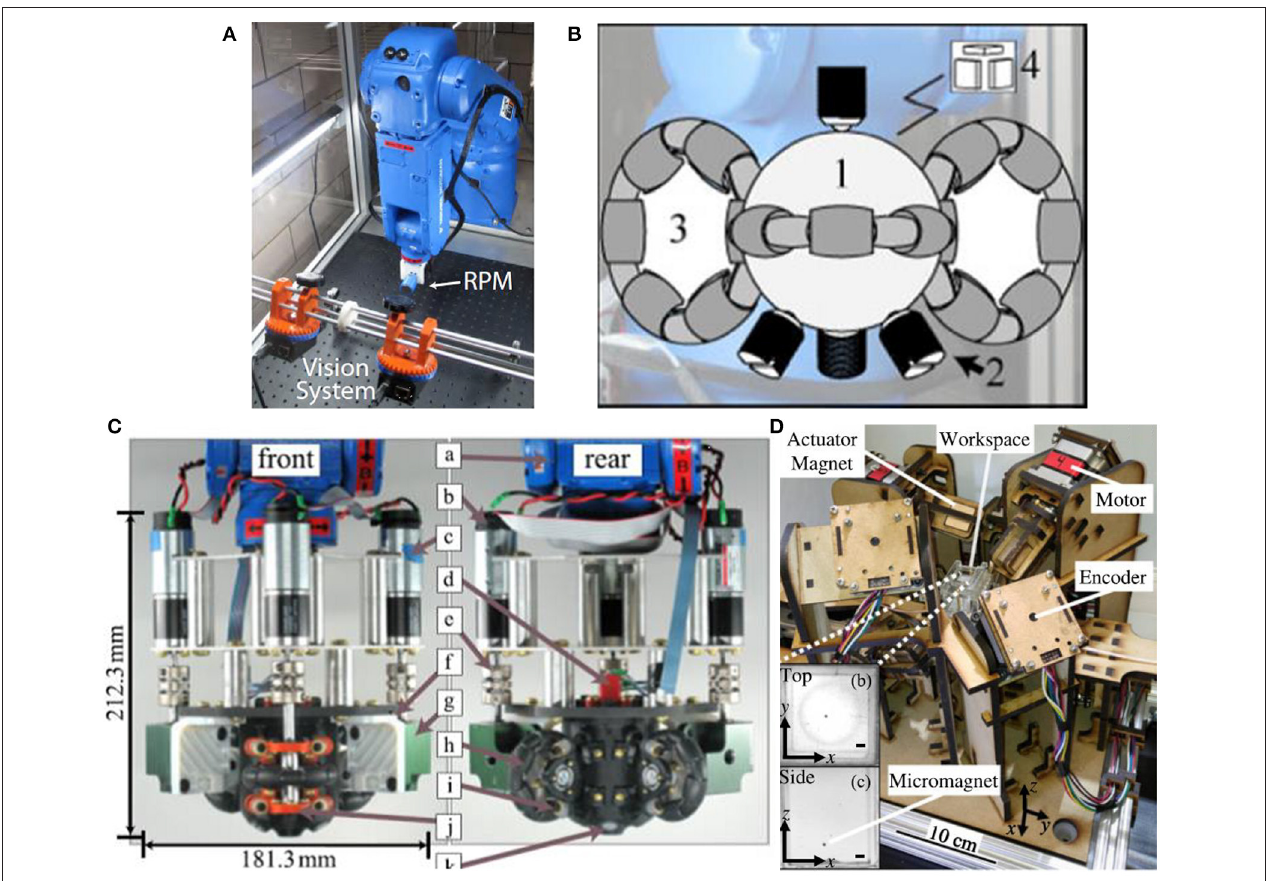
FIGURE 6 | (A) Single rotating permanent magnet control system that rotates around a fixed rotation axis (Mahoney and Abbott, 2012) (B) Main configuration of magnetic ball in SAMM, 4 ball screws prevent the magnetic ball from moving and three omniwheels control the magnetic ball to rotate freely (Wright et al., 2017) (C) Prototype of SAMM system as the end-effector is mounted mounted to the tool frame of robotic ( Wright et al., 2017) (D) Eight independently rotating permanent magnets control system ( Ryan and Diller,